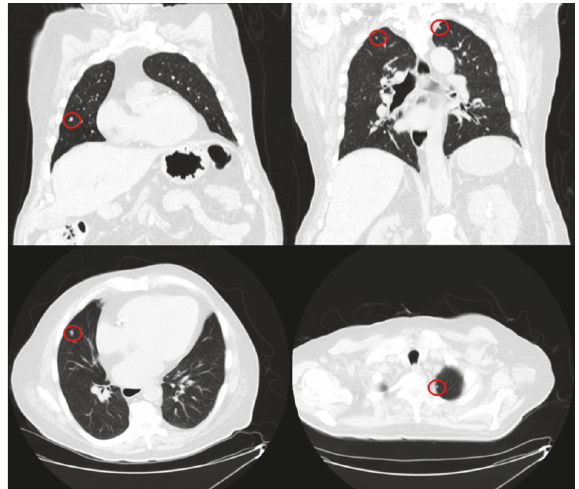
Figure 3: Computed tomography (CT) scan of the chest revealed multiple bilateral pulmonary and pleural-based nodules (red circles) suggestive of